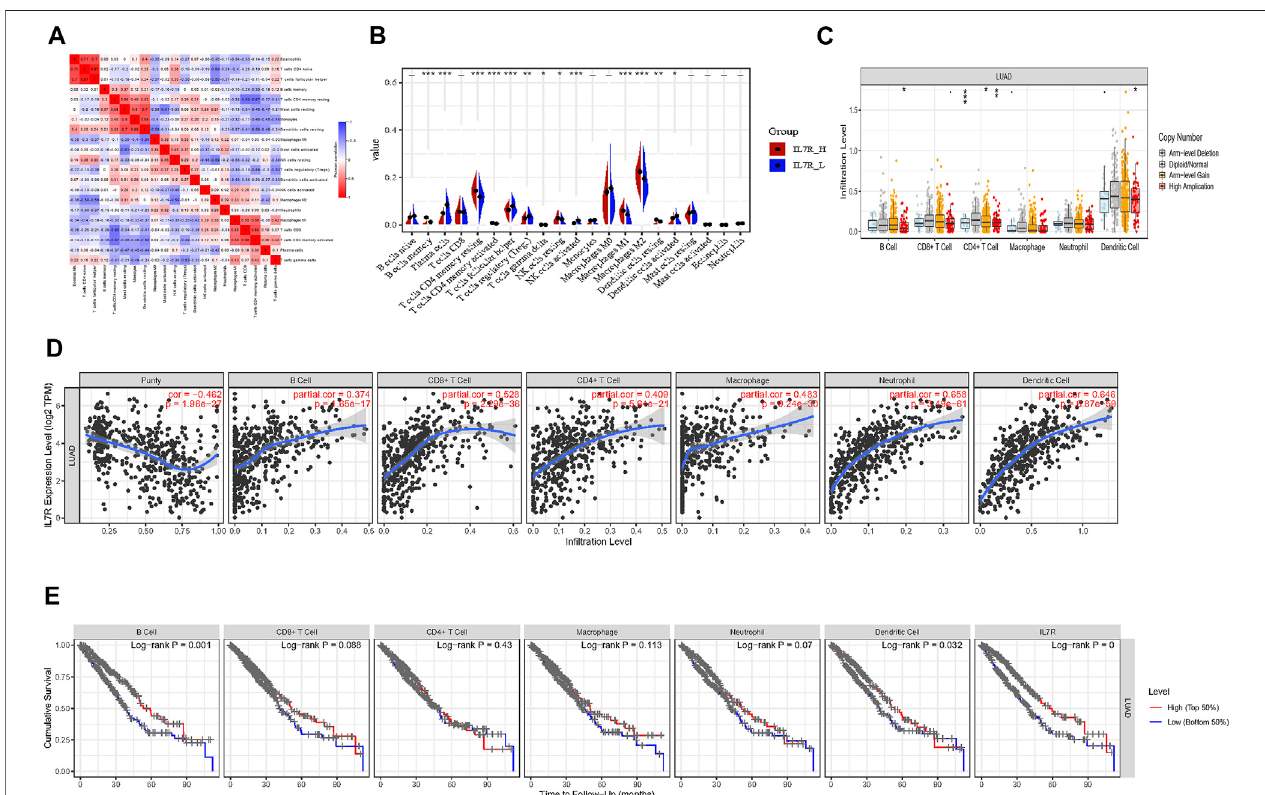
FIGURE7| IL7Risassociatedwithimmunecellin fi ltrationinlungadenocarcinoma. (A) Heatmapshowingthecorrelationbetween21kindsofTILandtheshadeof each tiny color box represented corresponding correlation value between two types of cells. (B) Violin plot showed the ratio differentiation of 21 kinds of immune cells between LUAD tumor samples with low or high IL7R expression, and Wilcoxon rank-sum was used for the signi fi cance test. (C) IL7R gene copy number variation signi fi cantly affected the in fi ltration levels of B cells, CD4 + T cells, and DC cells. (D) IL7R was negatively correlated with the tumor purity of lung adenocarcinoma and positively correlated with the expression of B cells, CD8+T cells, CD4+T cells, macrophages, monocytes, and DC cells. (E) Survival analysis showed the overall survival of patients with lung adenocarcinoma was positively correlated with the expression of B cells, DC cells, and